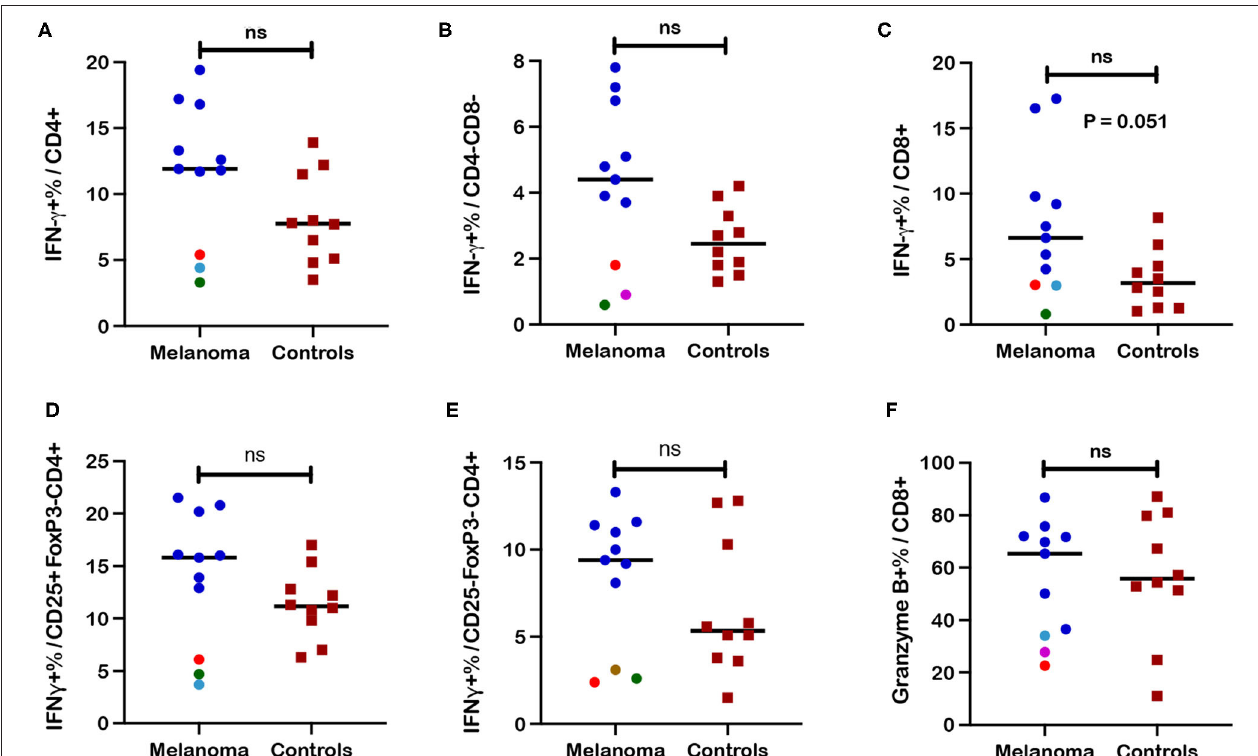
FIGURE 5 | Frequencies of interferon- γ + (IFN- γ ) and granzyme-B + T cell subsets after ConA stimulation in blood from canine melanoma patients and healthy controls. Median frequencies of IFN- γ + cells after ConA stimulation were determined in (A) CD4 + , (B) CD4-CD8-, and (C) CD8 + T cells by intracellular cytokine staining (ICS) and flow cytometry and compared between patients and healthy controls. Median frequencies of INF- γ + cells after ConA stimulation are also shown for (D) CD25 + FoxP3- (activated) and (E) CD25-FoxP3- (quiescent) CD4 + T cells and compared between patients and controls. (F) Induction of granzyme B after ConA stimulation is represented by median frequencies of granzyme B + cells within the CD8 + T cell subset and compared between patients and controls. Colored dots represent outlier patients with green indicating subject P10, red indicating subject P11, purple indicating subject P12, turquoise indicating subject P14, and brown representing P15. Values described for IFN- γ + frequencies reflect values for stimulated cells after subtraction of values for unstimulated cells. Values described for granzyme B + frequencies do not reflect subtraction of values for unstimulated cells. Pair-wise analysis between patients and controls was conducted with the Mann Whitney test using GraphPad Prism software and two-tailed analysis. “ns” denotes not